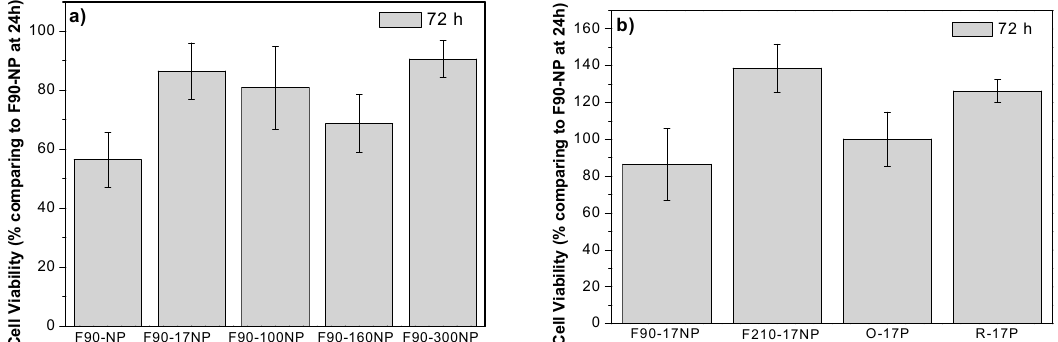
Figure 11. Cell proliferation of C2C12 cells seeded on ( a ) SiNPs/PVDF samples prepared at 90 °C with different sized nanoparticles and ( b ) SiNPs/PVDF samples with different morphologies. Cell cytoskeleton morphology, viability and adhesion were analysed by fluorescence microscopy for porous and non-porous films and SEM for fibre samples.